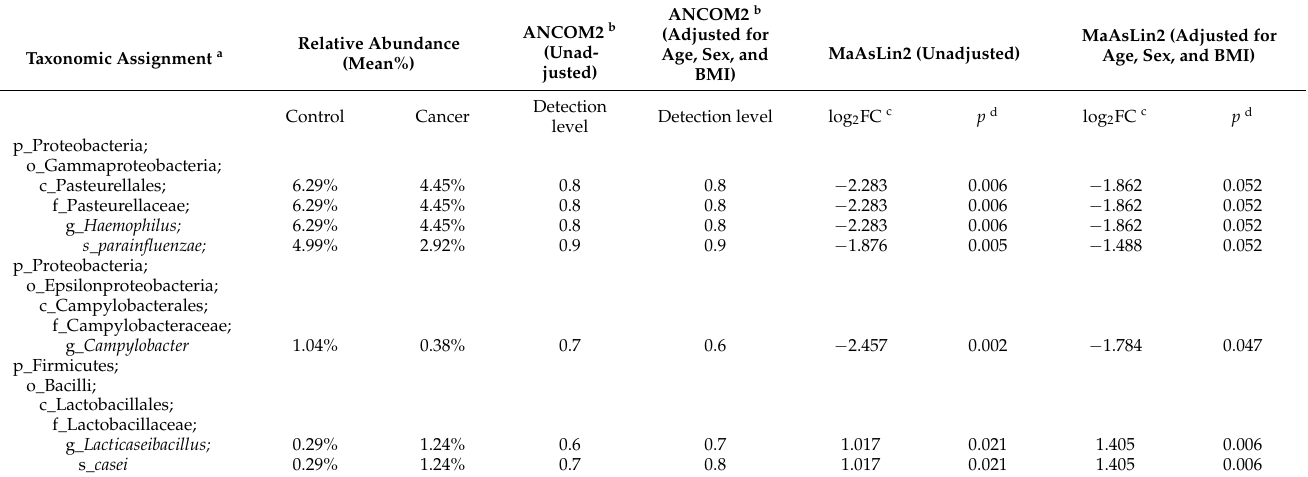
Table 2. Differentially abundant taxa between the control and gastric cancer